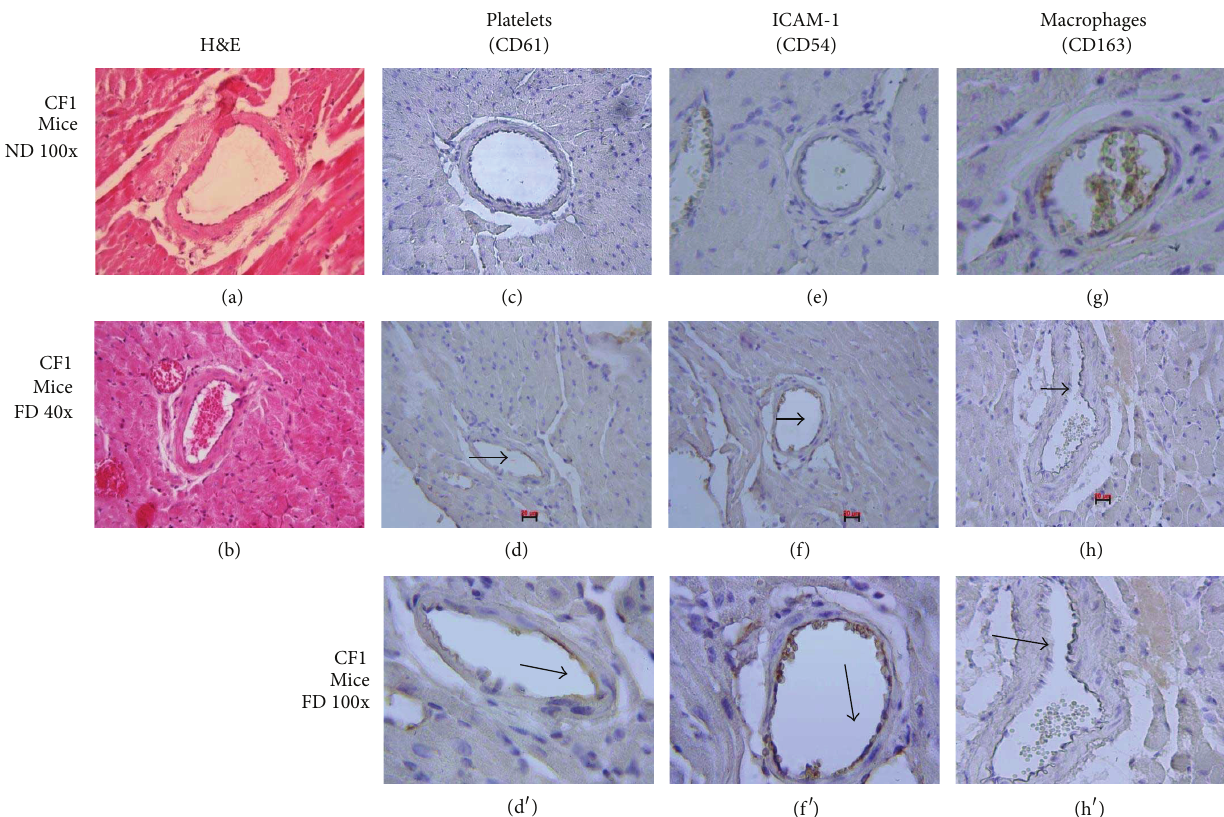
Figure 1: Coronary of CF1 mice a SM Model. ((a), (b)) Histological sections of CF1 mouse coronary artery ND and FD, stained with H&E (100x). (c) Histological section of coronary artery of CF1 mouse ND. ((d), ( d 󸀠 ) ) Histological sections of coronary artery of CF1